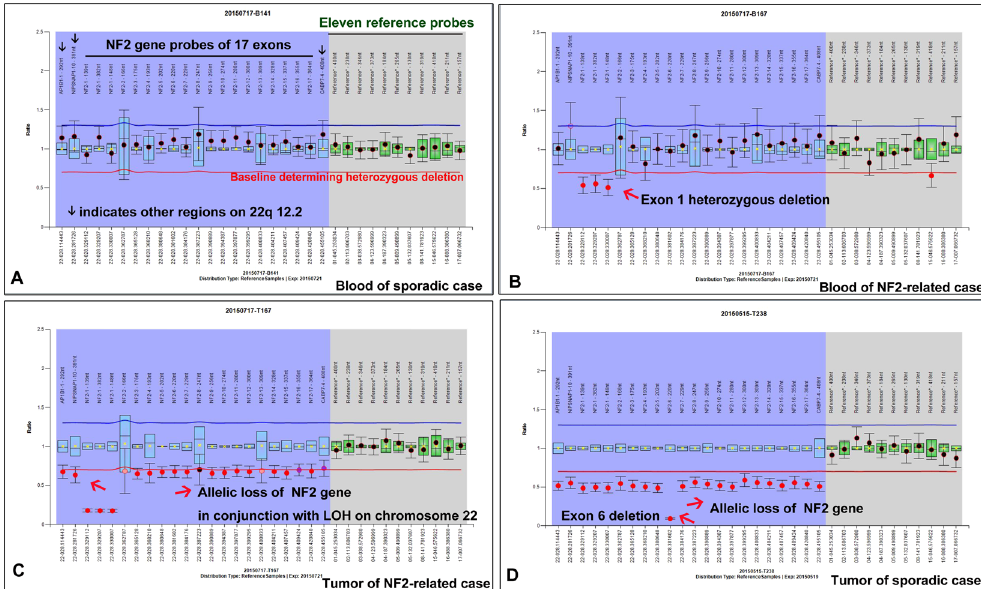
Figure 2. The detection of the exonic deletion and allelic loss of the NF2 gene by MLPA analysis. (A) Three probes located in other regions on 22q 12.2 were included as positive controls to identify a loss of heterozygosity (LOH). Eleven reference probes were included to detect different autosomal chromosomal regions. In the graph, the y-coordinate represented the Dosage Quotient (DQ) and 0.4 < DQ < 0.7 was considered to have a heterozygous deletion. No exonic deletions were found in the blood of sporadic cases. (B) In NF2-related VSs, a deletion of exon 1 was seen in the lymphocytes. (C) Somatic allelic loss as the second genetic event was demonstrated in matched tumours, in conjunction with LOH. (D) Somatic deletion of a single exon (the first hit) followed by the allelic loss of the NF2 gene were also observed in one case of sporadic VSs.